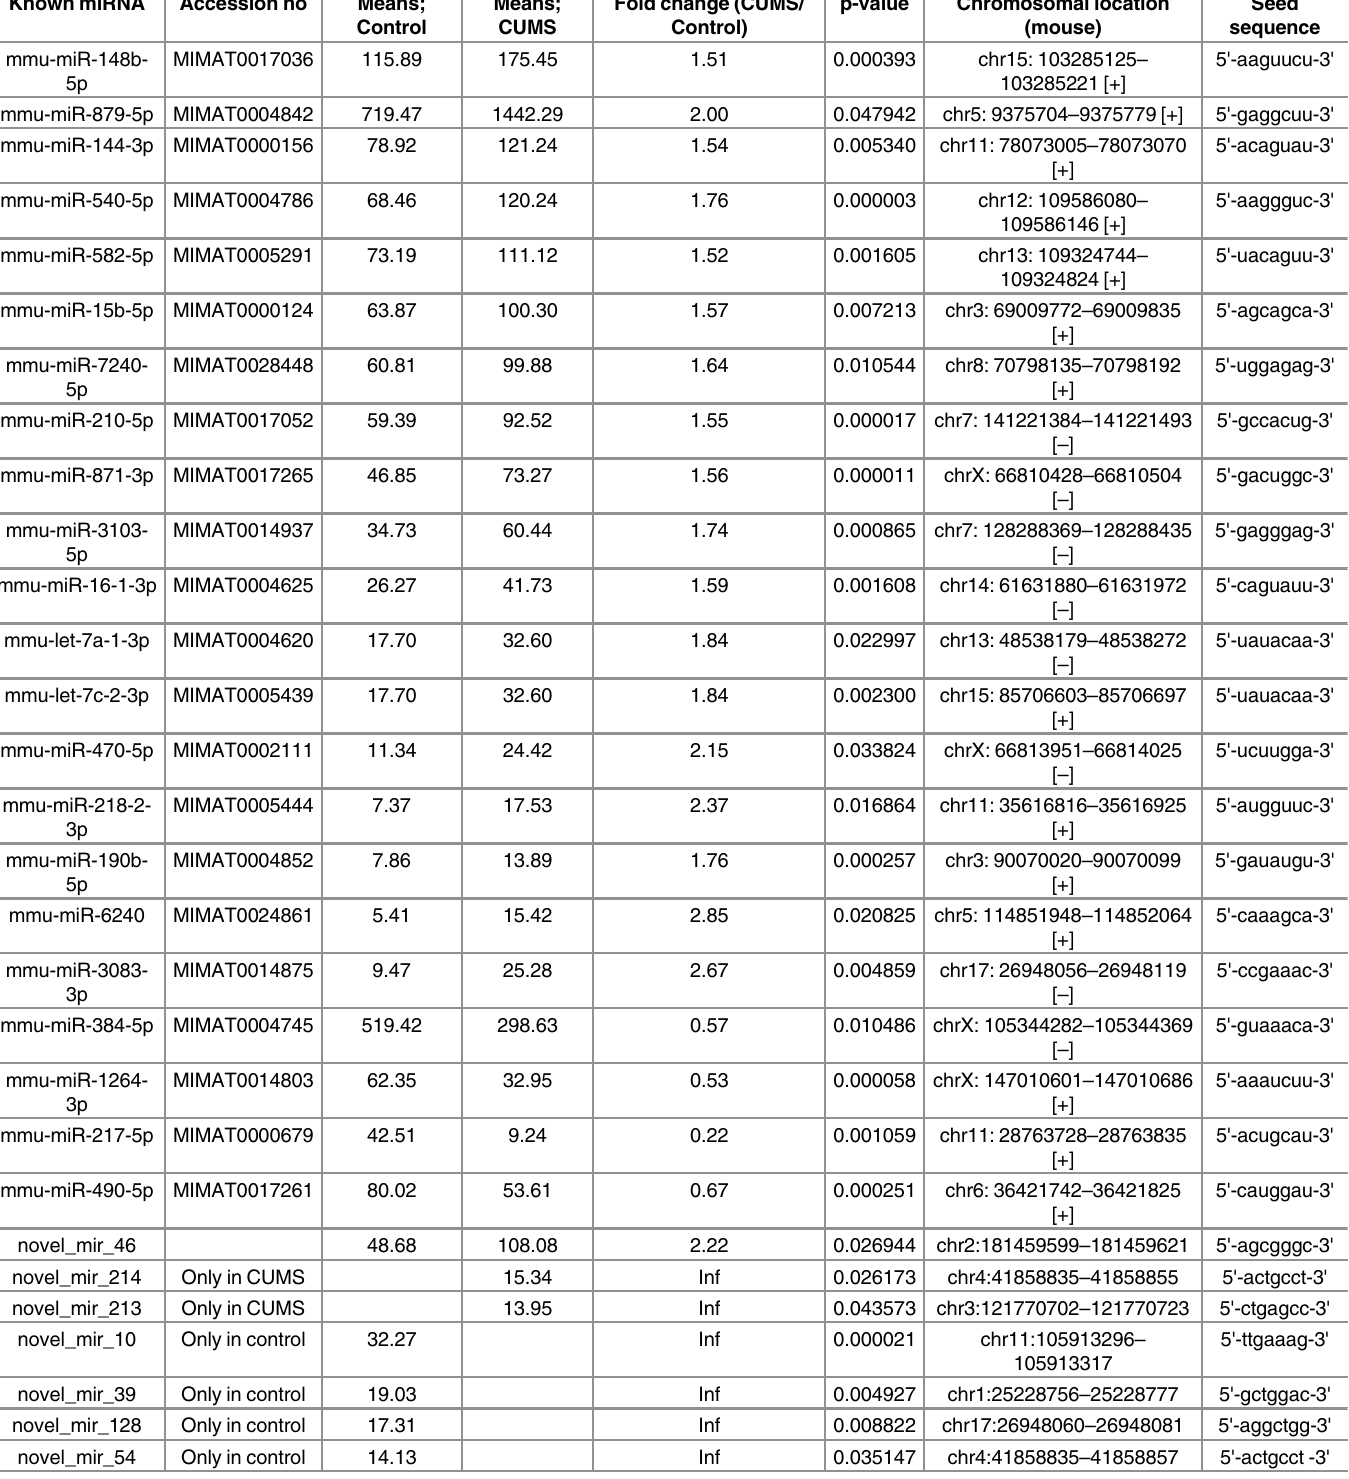
Table 3. miRNAs with quantitative change over 1.5 folds and their characteristics. Known